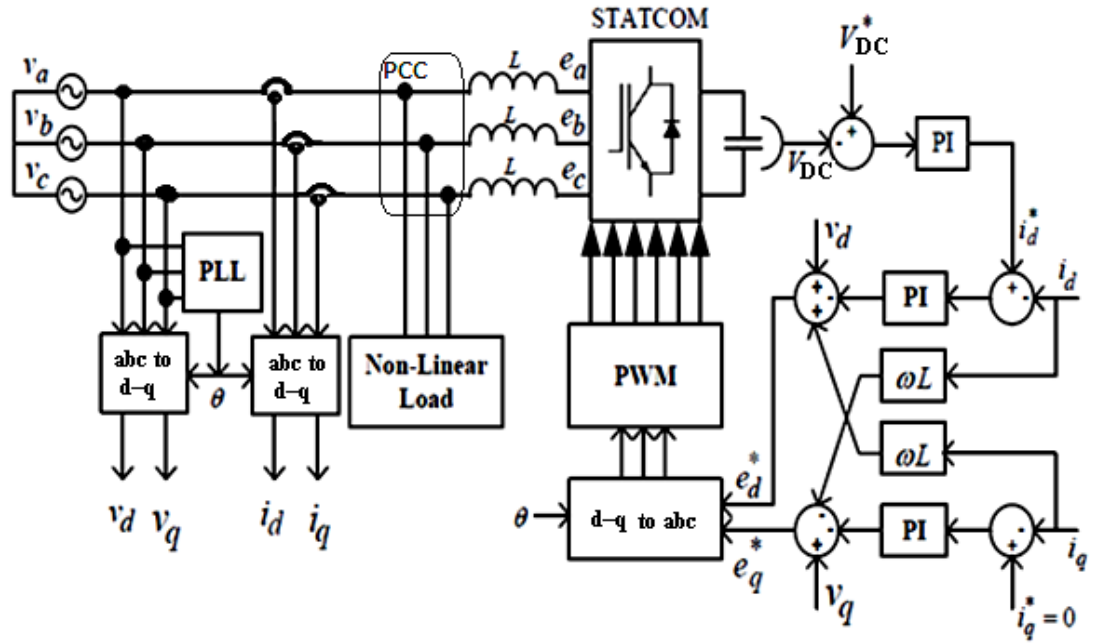
Fig. 1. Schematic of the proposed STATCOM control